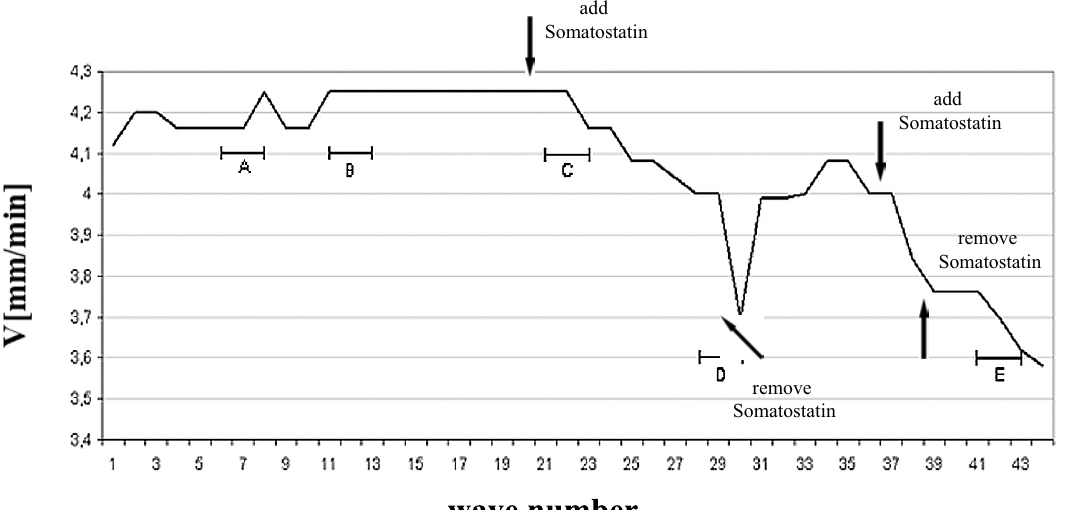
Fig. 4 – Wave propagation velocity (mm/min) through a circle of 20 mm length versus the wave number. The intervals A to E show the waves that have the electrophysiological concomitants shown in Figure 5.